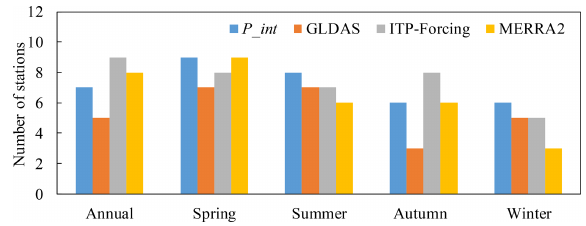
Figure 12. The number of meteorological stations (total of nine) which present the same trends as the different precipitation prod- ucts, according to Fig. 11.